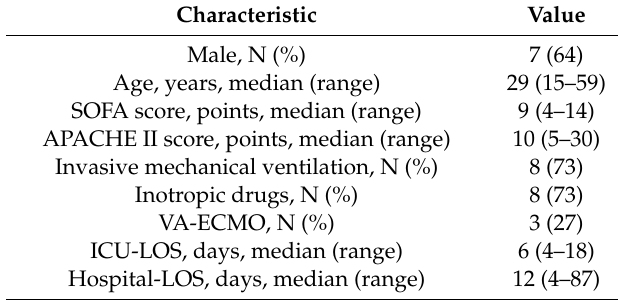
Table 1. Demographic and clinical, characteristics of patients with hantavirus cardiopulmonary syndrome (HCPS) monitored with transpulmonary thermodilution (TPTD). Sequential organ failure assessment (SOFA), acute physiology and chronic health evaluation (APACHE II),